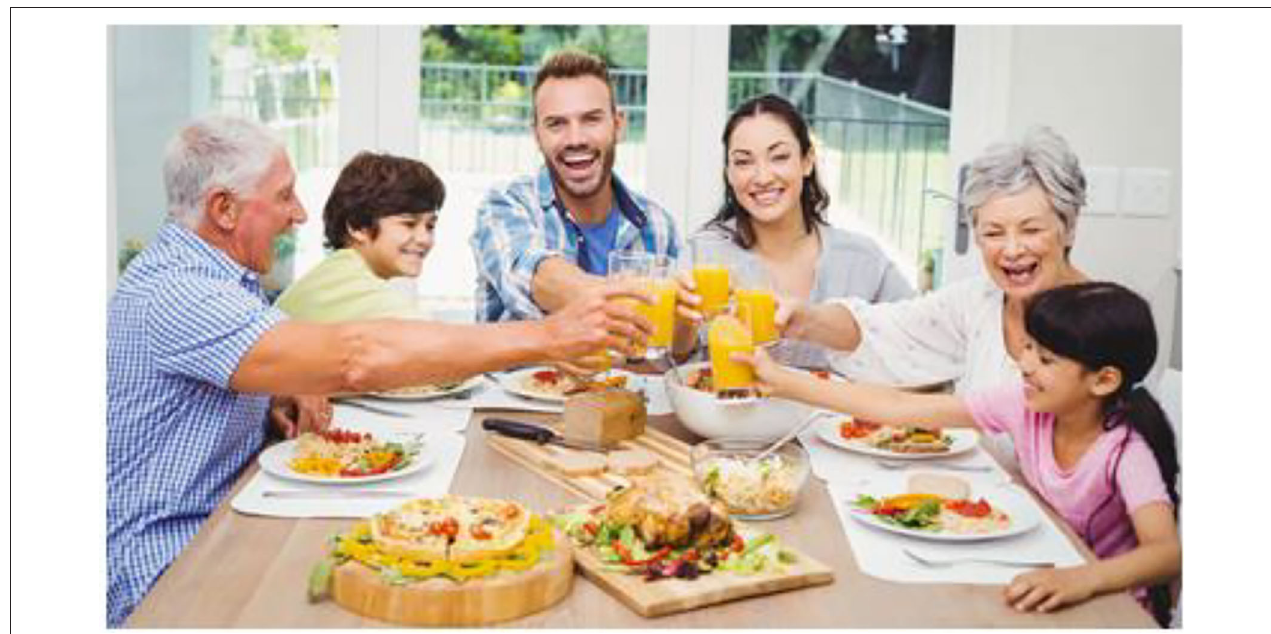
FIGURE 2 | Depiction of “sensory interaction